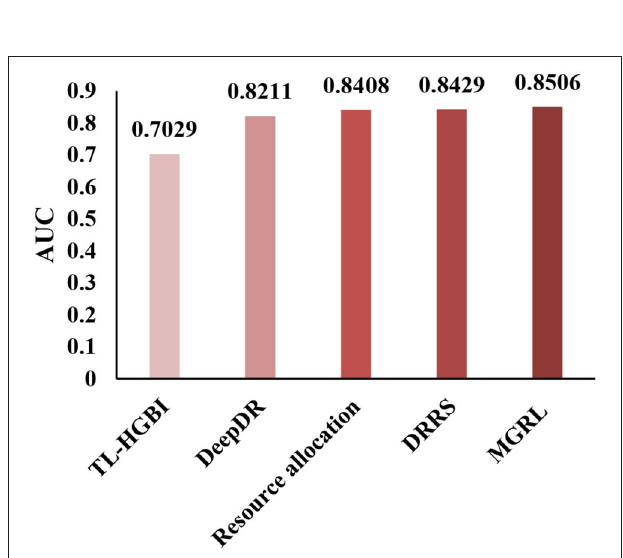
FIGURE 5 | Under the CTD Dataset (contains 18,416 drug-disease associations between 269 drugs, and 598 diseases.), TL-HGBI, DeepDR, Resource allocation and DRRS were compared between the AUCs obtained under five-fold